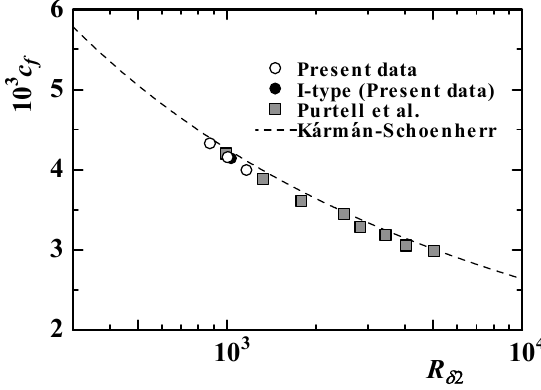
Fig. 14 Variation of skin friction coefficient c